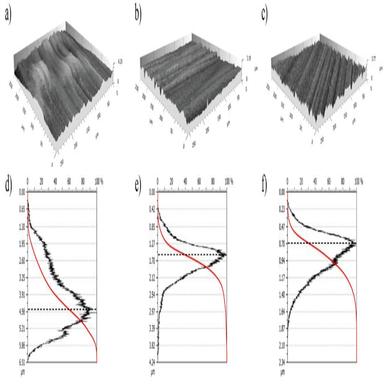
3D reconstruction images of titanium surfaces (a-c) and graphs showing the corresponding probability density function (black line) and Abbot-Firestone curve (red line)(d-e), the abscissa 0 is set at the highest point of the surface and the axis is directed downward, inside the surface: a,d) Ti(A-HC-H); b,e) Ti64(SrAg); c,f) Ti64 (HF-H2O2). The dashed lines represent the average line of the surfaces.